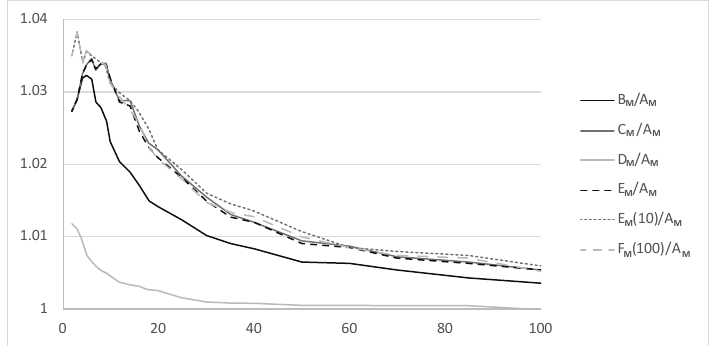
Figure 5. On this plot we can observe the quotients with A M for the instances from the first subset of the third dataset, corresponding to k = 4. The x axis represents the size of each partition n , while y axis represents the quotient. Compared to results from Figure 4, we can see that on this dataset, the difference between B M , C M , E M , E M (10) and F M (100) are becoming almost negligible when n